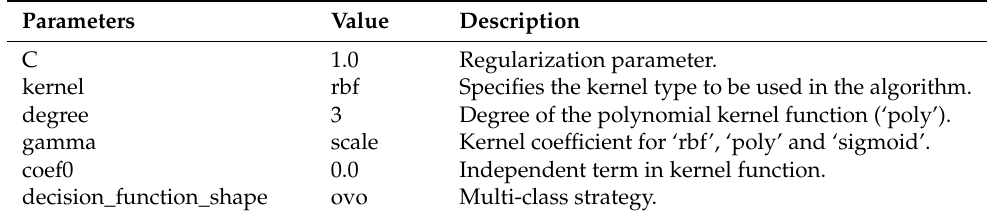
Table 6. SVM (OVO) parameters from scikit-learn library. Parameters Value